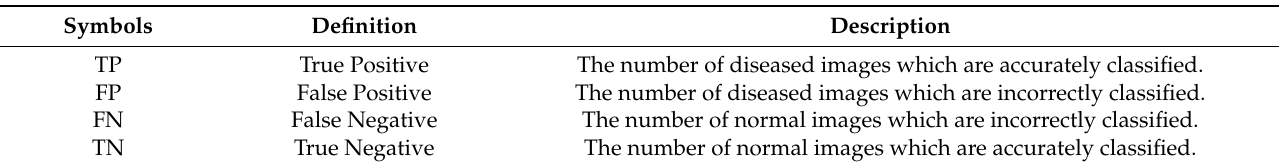
Table 3. Classification performance using original dataset.